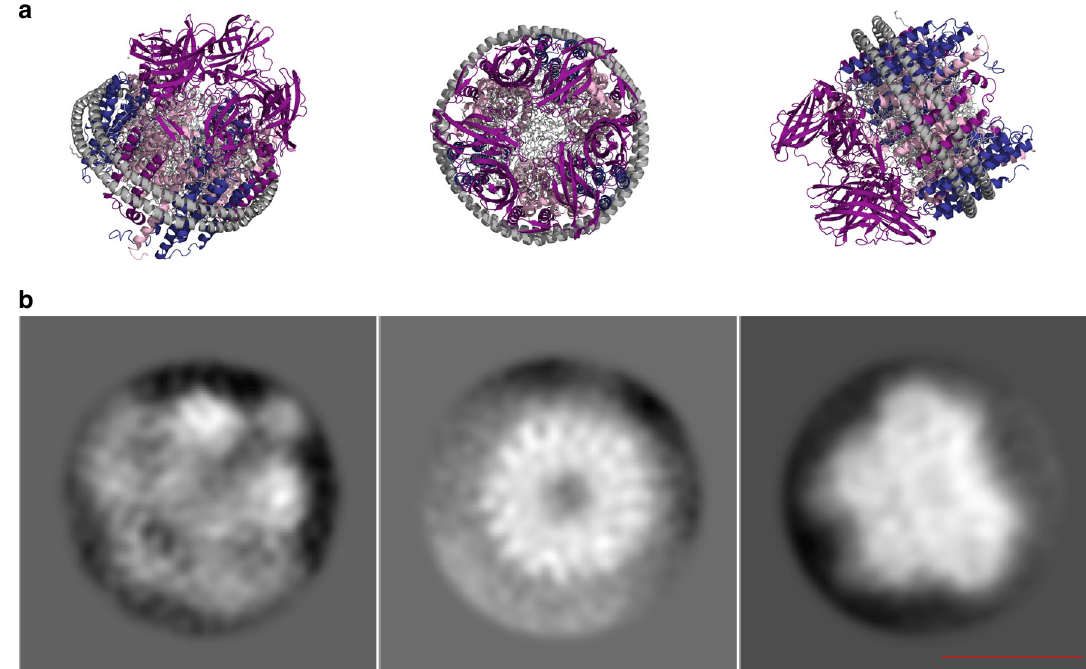
Fig. 4 Cryo-EM 2D class averages of 20Z-pMMO in MSP2N2 nanodiscs. a A model of a pMMO nanodisc complex generated from the crystal structures of Methyloccocus capsulatus (Bath) pMMO (PDB accession code 3RGB) and MSP1D1 (from PDB accession code 6CC9). This model is for illustrative purposes and is not from 2D class averages. b Tilted, top, and side views of 2D class averages of 20Z-pMMO reconstituted in nanodiscs. A representative scale bar is shown as a 10 nm red